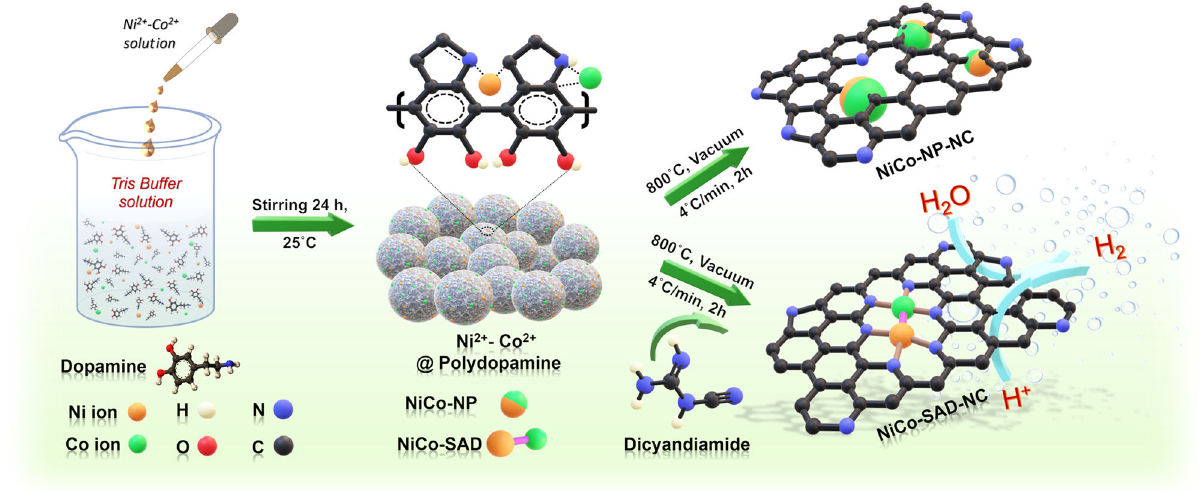
Fig. 2 Synthesis strategy for single-atom dimer. Schematic illustration of the synthetic strategy for the NiCo-SAD-NC and NiCo-NP-NC: (I) trapping metal ions (Ni and Co) into the polydopamine (PDA) via self-polymerization of dopamine; (II) generation of NiCo-NP-NC and NiCo-SAD-NC through calcination treatment upon modulating nitrogen containing precursor (dicyandiamide)